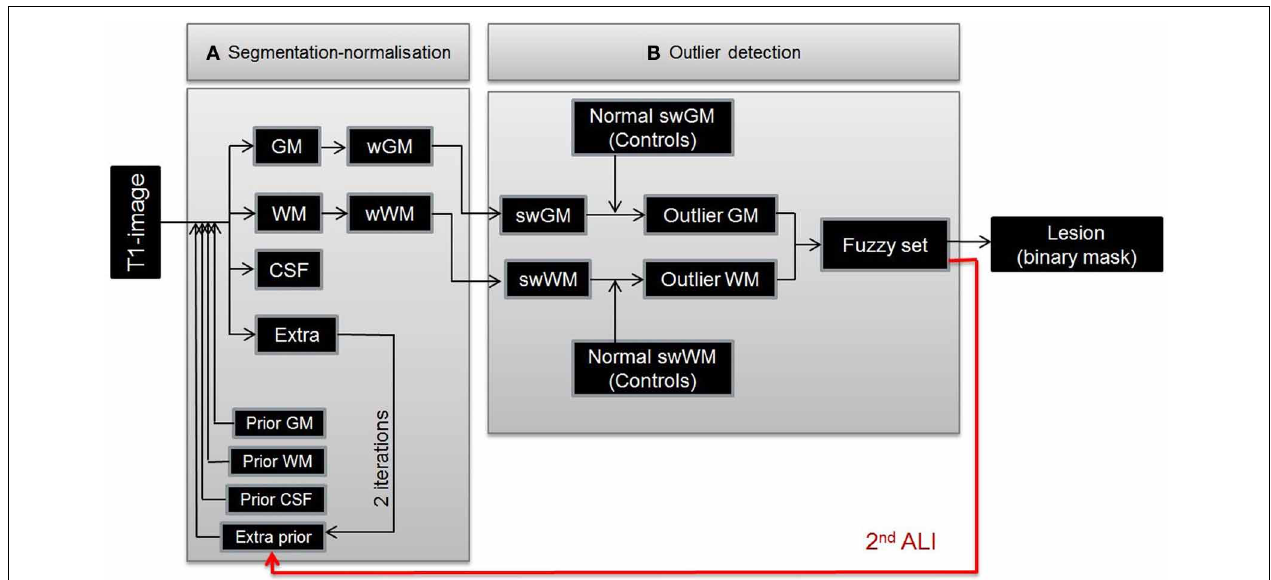
FIGURE 1 | Illustration of ALI procedure. The method identifies lesion in two core procedures. (A) A modified segmentation-normalization that identified the likelihood that each voxel belonged to one of four different tissue types and (B) a fuzzy clustering algorithm that identified voxels where the tissue probability maps differed from those in healthy controls. The red arrow shows